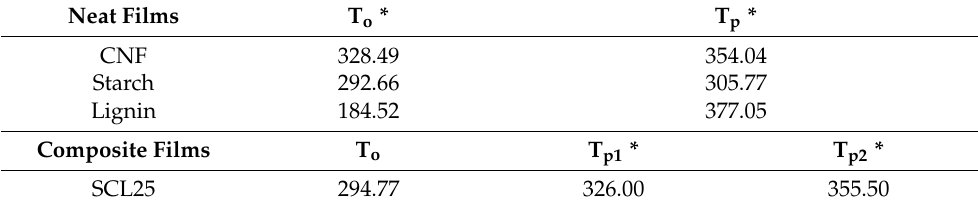
Figure 8. Thermo gravimetric (TG) ( a ) and derivative thermo gravimetric (DTG) ( b ) curves of starch, CNF, lignin and composite films. Table 2. Thermal properties of neat films and composite films ( ◦